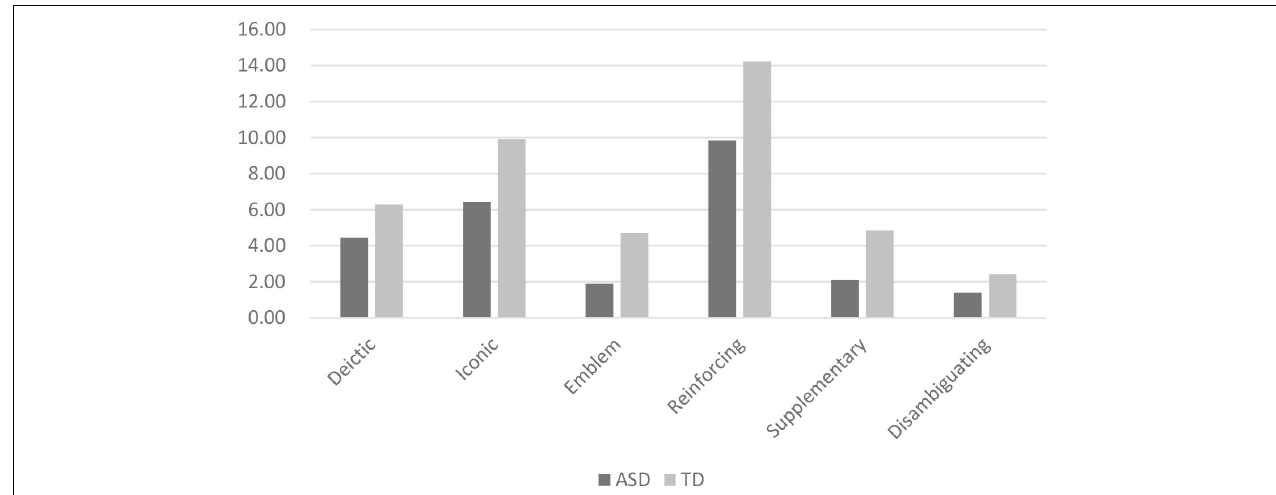
FIGURE 1 | Number of gestures by gesture type and gesture-speech